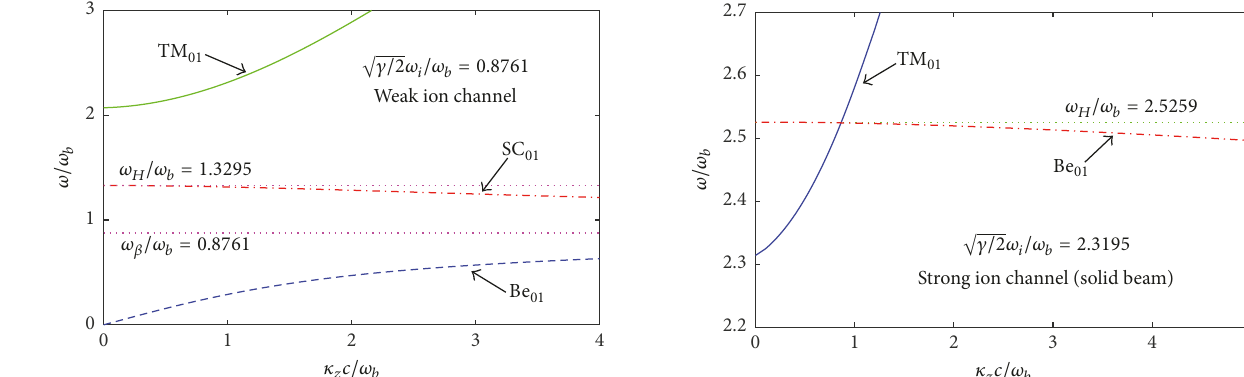
Figure 17: For solid beam, the TM wave only has one branch and can interact with the betatron wave in strong ion channel case. The beam radius is taken as 𝑎 = 0.25𝑅 ; the Lorentz factor is 𝛾 = 6